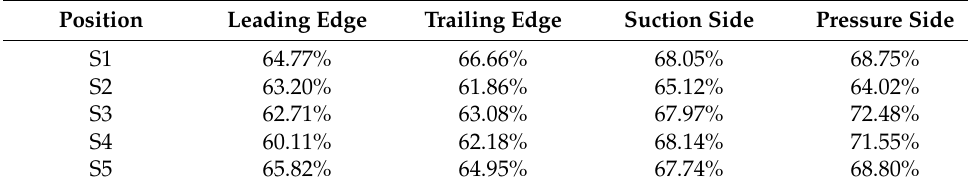
Figure 16. The quantitative results of the characteristic parameters of the γ ’ phase in the typical positions of the single crystal blade section S1–S5, and S1–S5 are the section positions. ( a ) Size, ( b ) Geometry factor. Table 4. Area fraction of γ ’ phase in all